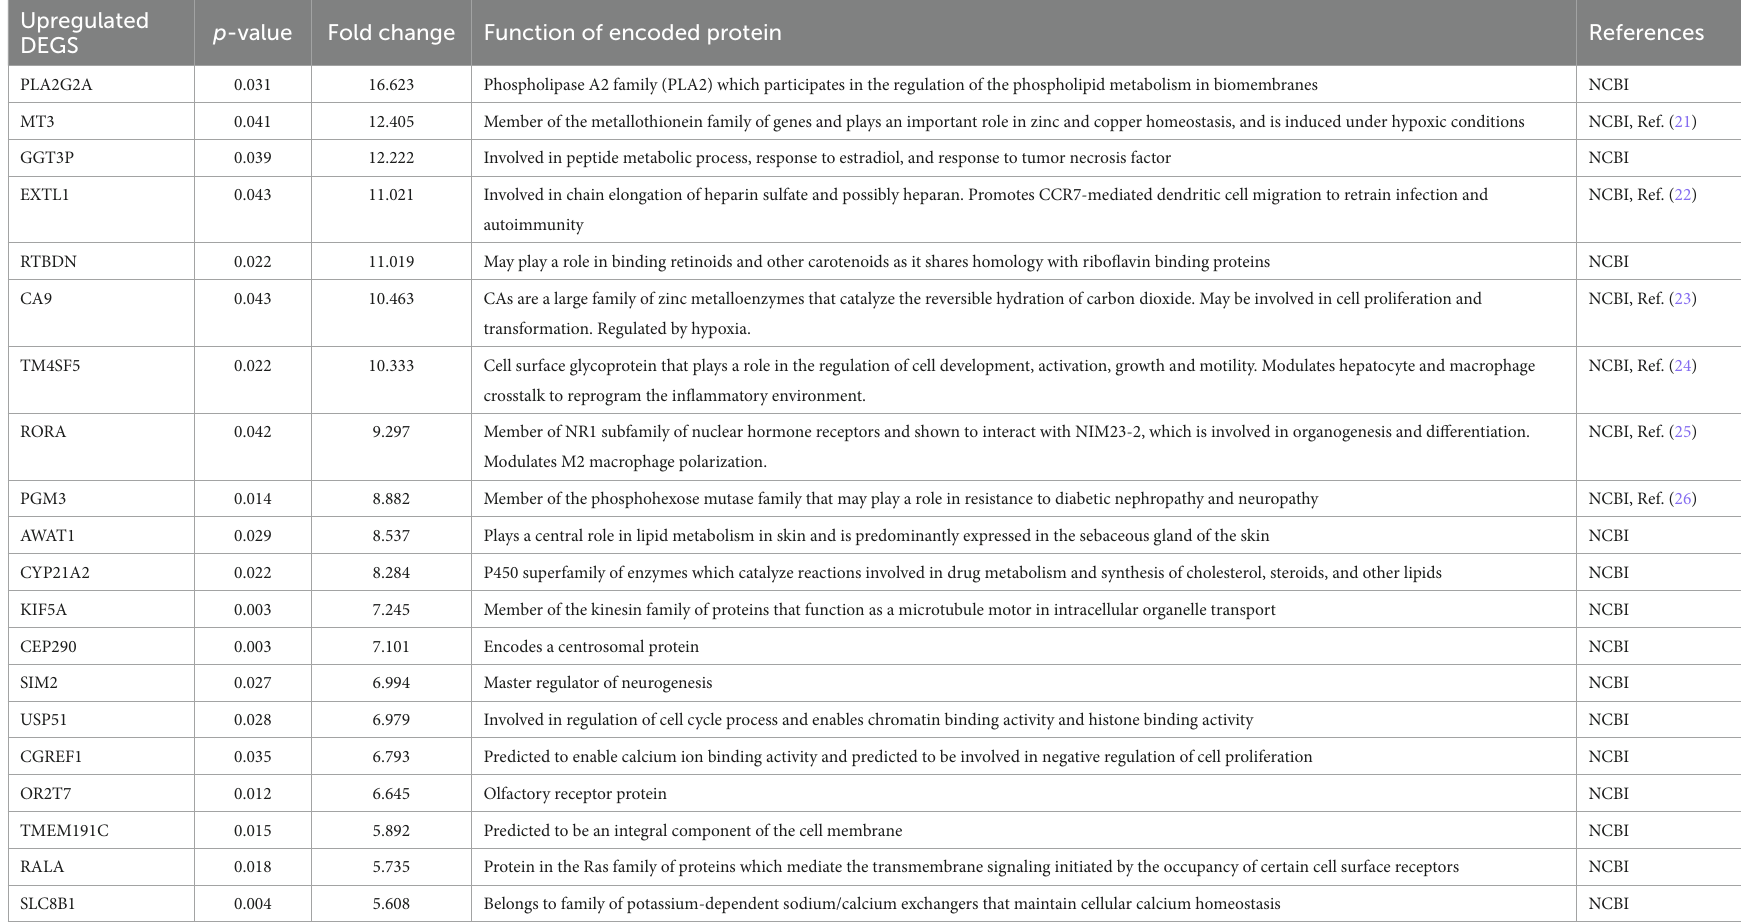
TABLE 2 Top 20 upregulated and downregulated protein encoding DEGs ( p < 0.05) in ultrasound-treated vs. sham-treated wounds. Upregulated p -value Fold change Function of encoded protein DEGS